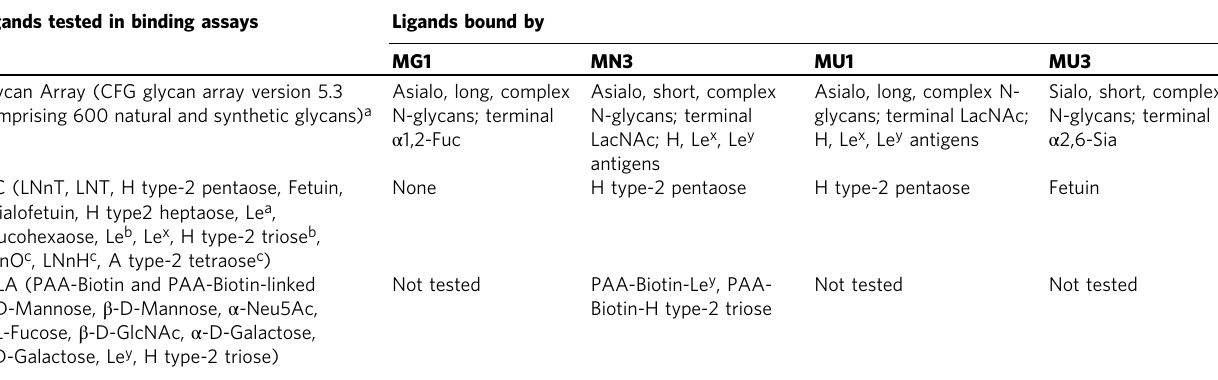
Table 1 Ligand binding pro fi le of clones (MG1, MN3, MU1, and MU3) identi fi ed by biopanning against mucin. Ligands tested in binding